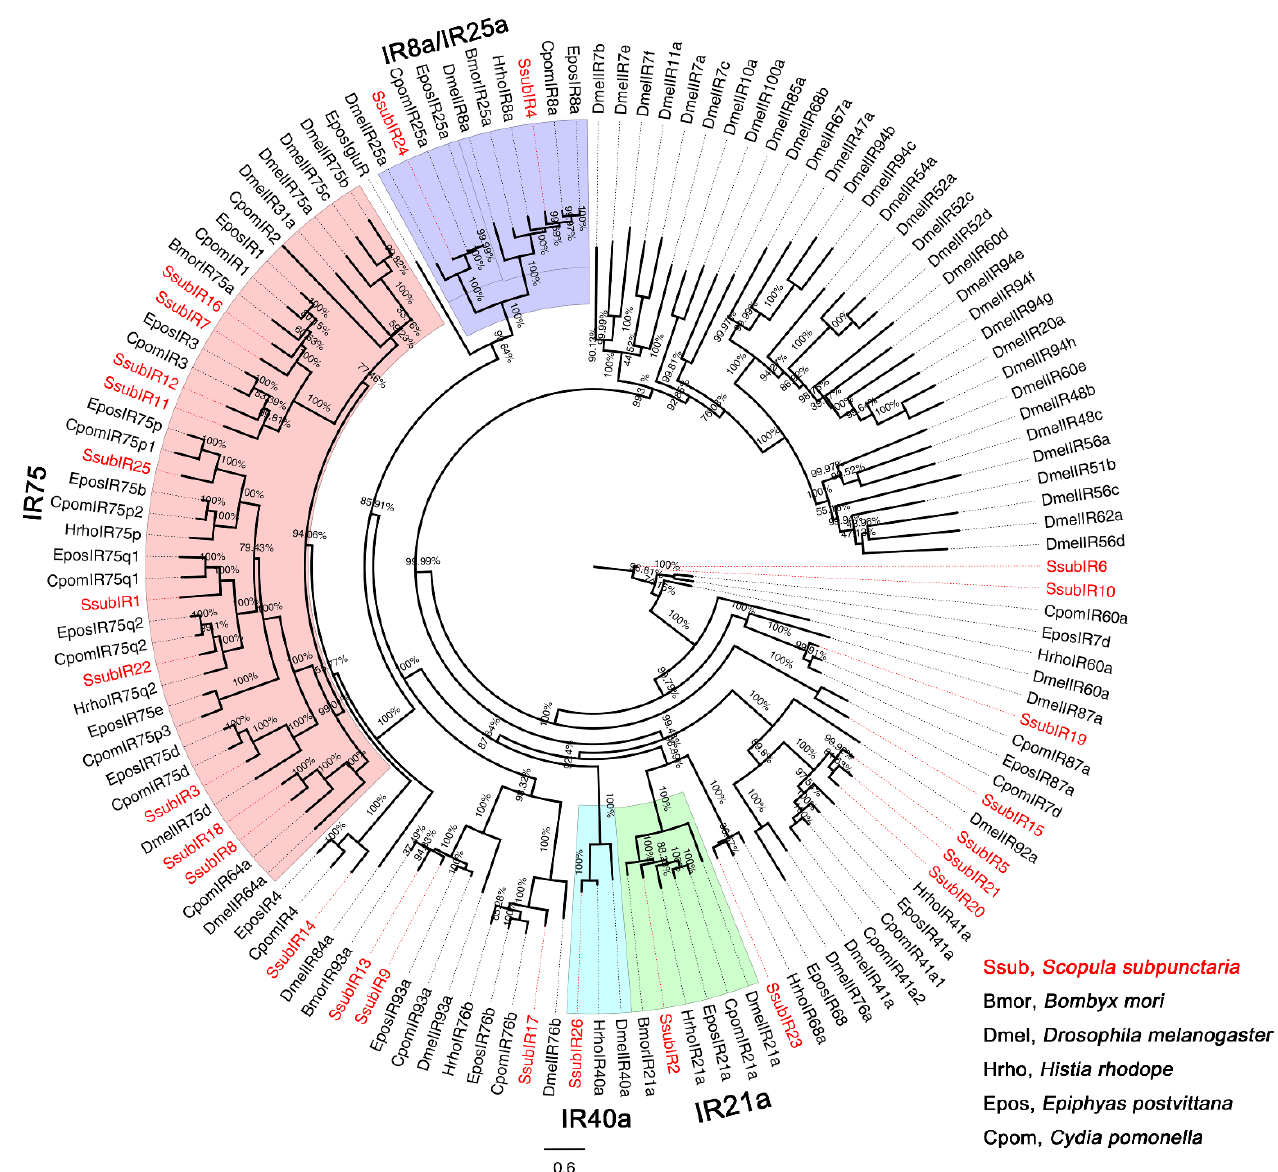
Figure 3. Phylogenetic analysis of SsubIRs with other lepidopteran insects. The percentages on the branches show the bootstrap values. The group in purple was classified as “IR25a/IR8a”. The group in red was classified as “IR75”. The phylogenetic tree was constructed in PhyML3.1 using the maximum likelihood method.